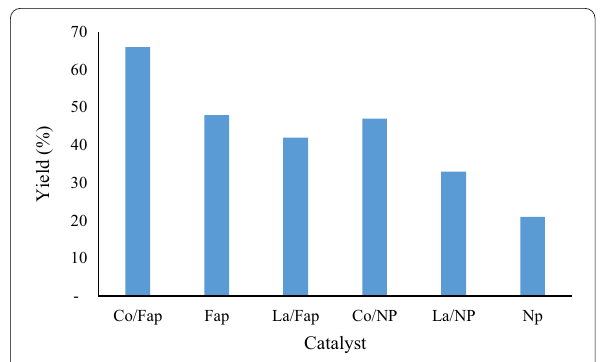
Fig. 4 Synthesis of spiropyrimidine by different